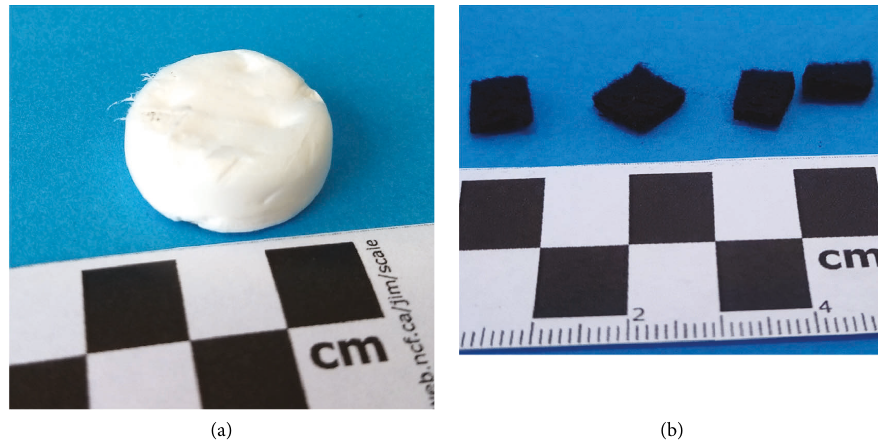
Figure 1: In (a) BNC sample after supercritical drying. (b) Kynol nonwoven samples are cut into 1 × 1cm